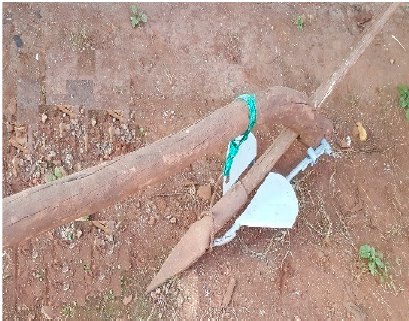
Figure 2. Berken Maresha assembled to the traditional ard plough.